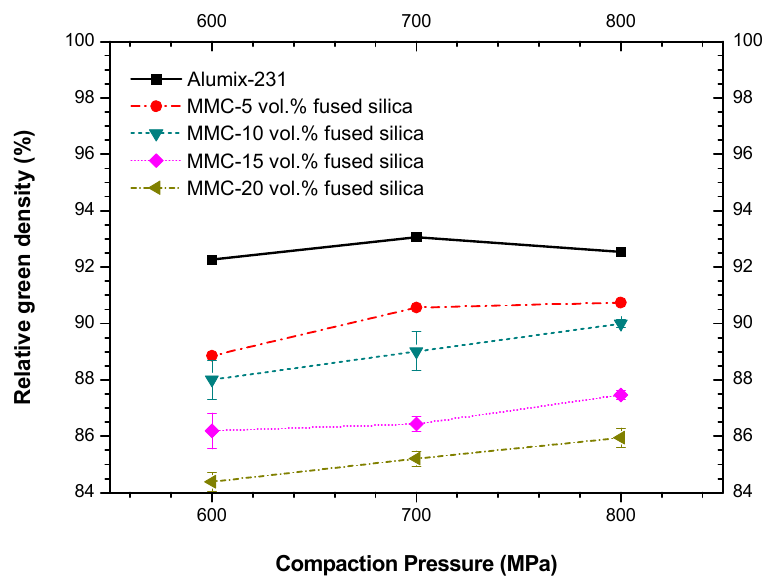
Figure 3. Green densities for neat Alumix-231 and MMCs as a function of uniaxial compaction pressure. For some samples error bars are smaller than the symbols.